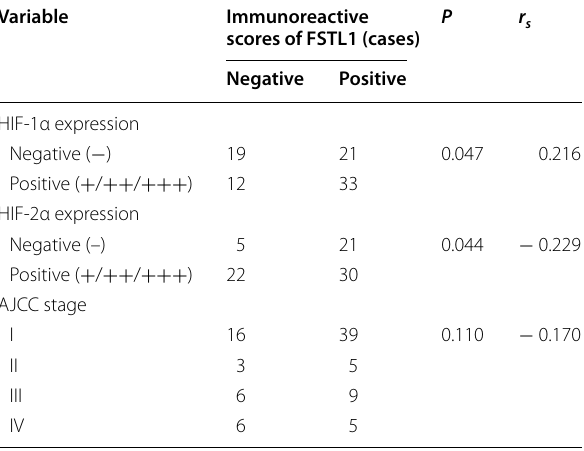
ccRCC clear-cell renal cell carcinoma; FSTL1 follistatin-like protein 1; HIF hypoxia- inducible factor; AJCC American Joint Committee on Cancer; r s Spearman rank correlation coefficient